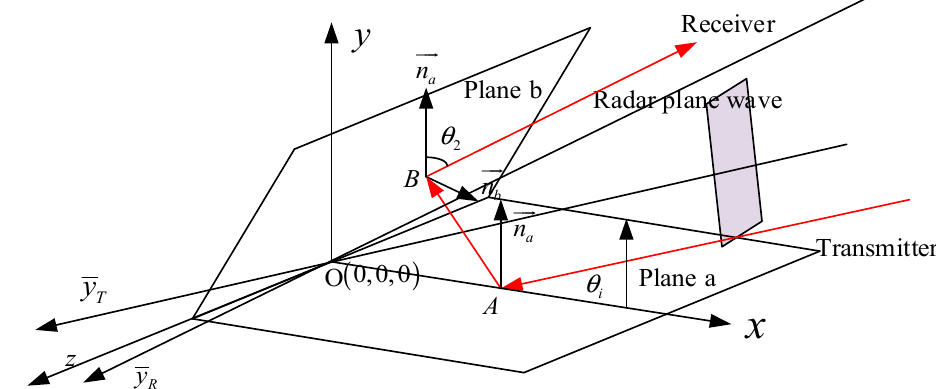
Figure 3. Double-bouncing reflection path of an acute dihedral corner case.